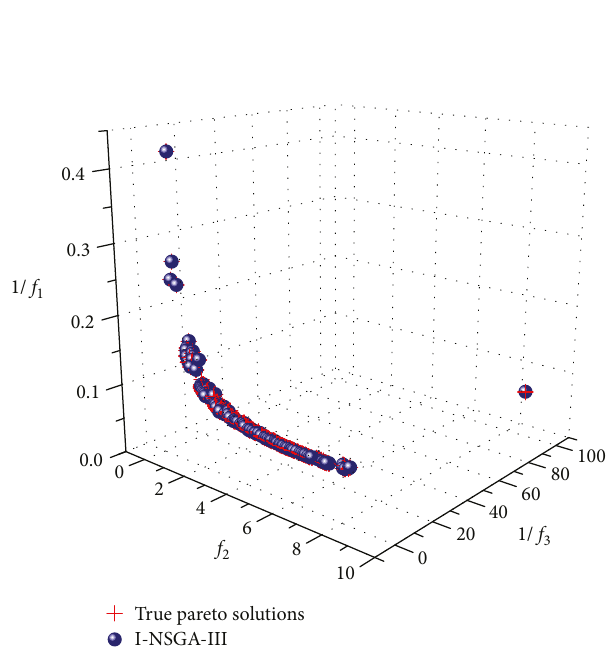
Figure 4: Plots of the true PSs and the fi nal PSs found by I-NSGA- III on the speci fi c instance.